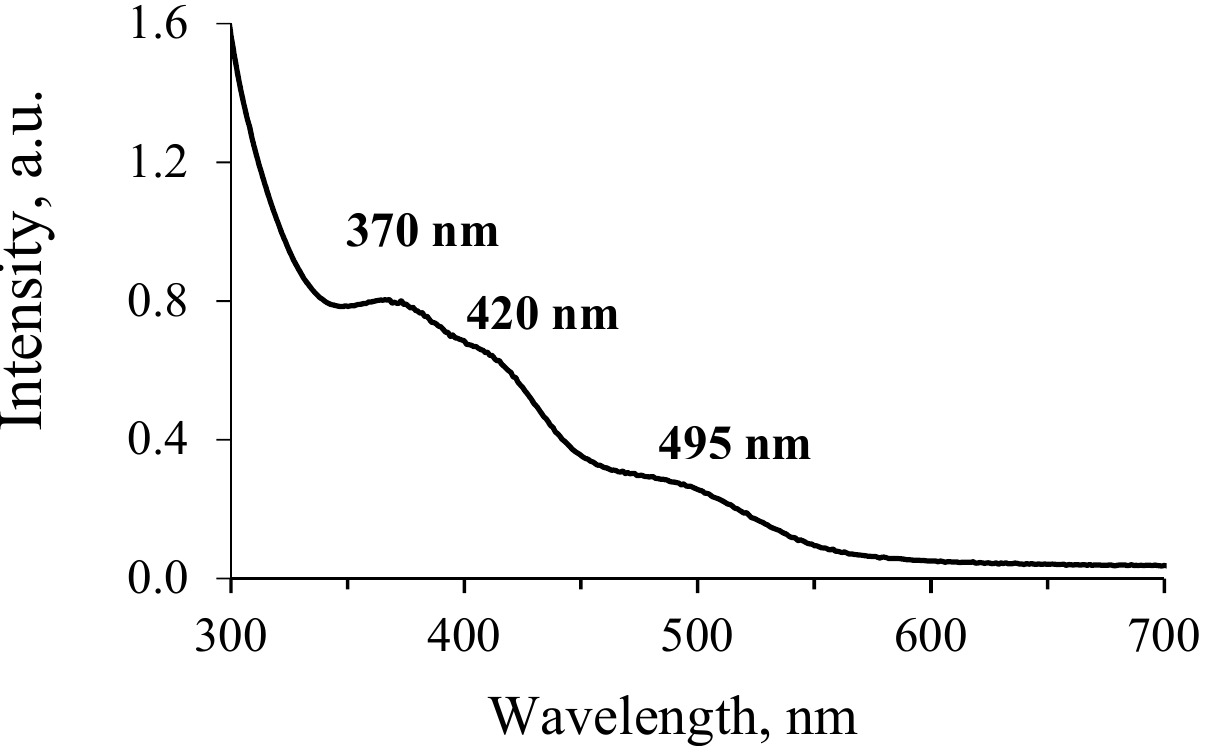
Figure 11. UV-Vis spectroscopy of the stock solution of compound III a few minutes after the addition of HTcO 4 .